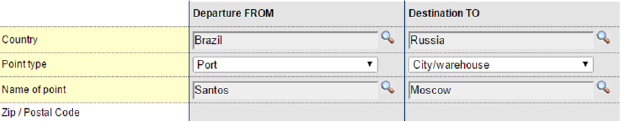
Fig. 6. Graph of intermodal transportation route (sample: Santos – Tallinn/Muuga – Moscow). Stage 1: Definition of transport route